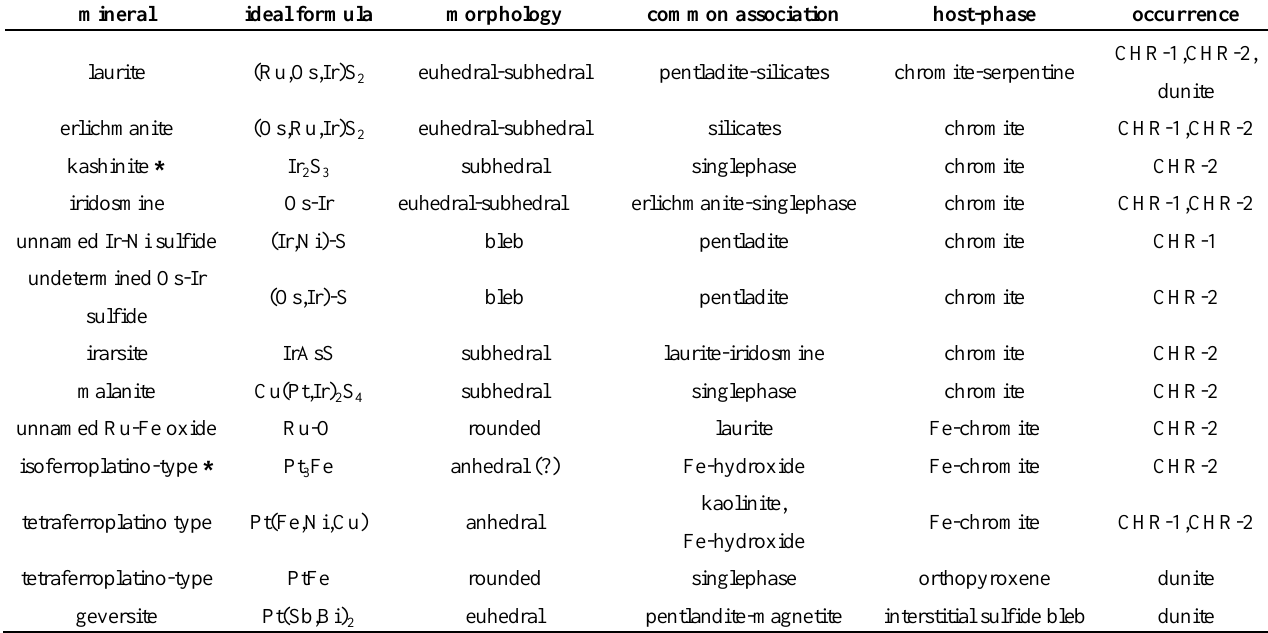
Table 1. Mineralogy and texture of Platinum-group minerals (PGM) in chromitites and associated dunite of the Niquelândia layered